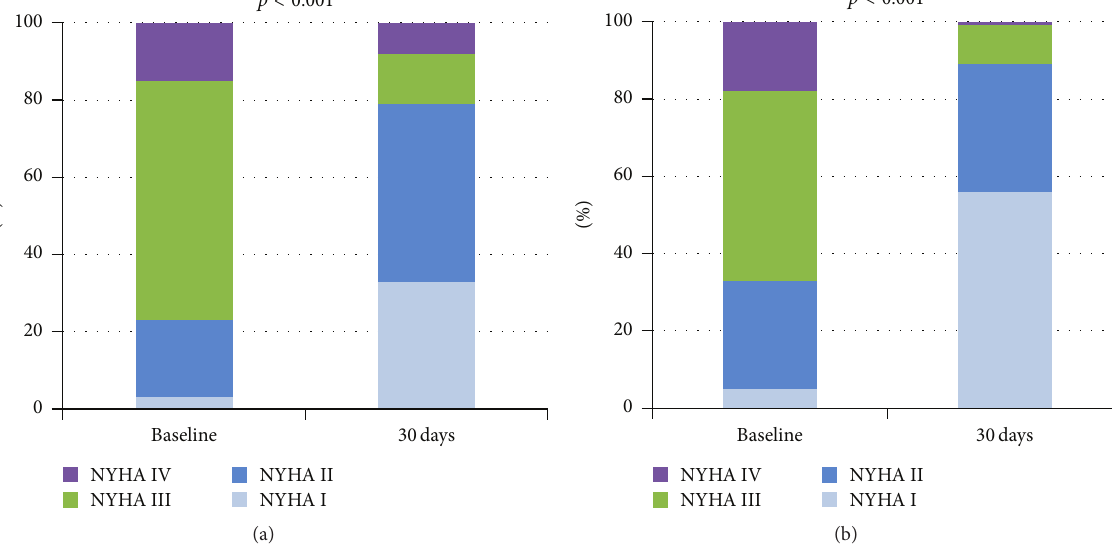
non-LFLGAS), and density ( 818±40 HU versus 747±18 HU, 𝑝 = 0.07 for LFLGAS, and 867 ± 24 HU versus 817 ± 12 HU, 𝑝 = 0.10 for non-LFLGAS), albeit without reaching statistical